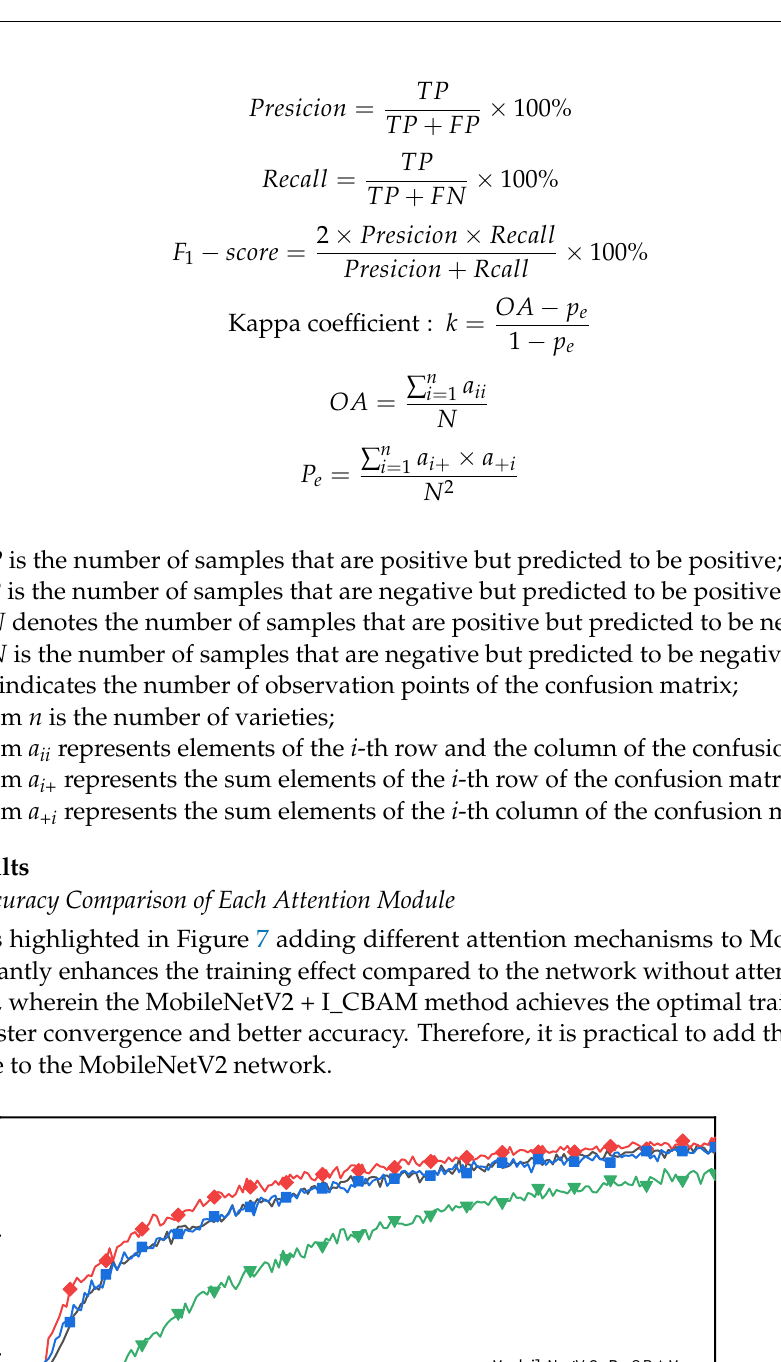
Table 3. Results of using reduction ratios for I_CBAM_MobileNetV2.